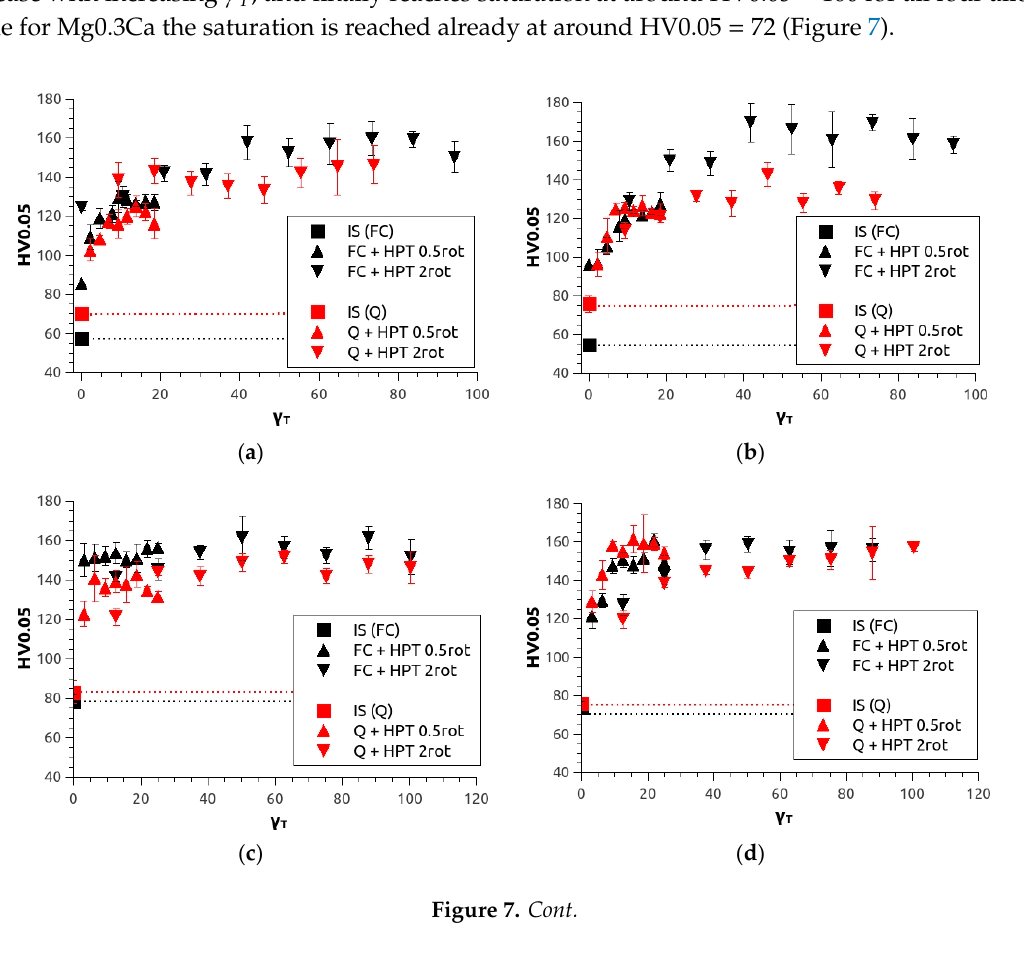
( e ) Figure 7. Microhardness results for ( a ) Mg5Zn0.3Ca, ( b ) Mg5Zn, ( c ) Mg5Zn0.15Ca, ( d ) Mg5Zn0.15Ca0.15Zr and ( e ) Mg0.3Ca in the initial state (IS–dotted line) after furnace-cooling (FC, black) and quenching (Q, red) and additional HPT deformation at room temperature at 4 GPa, 0.5 and 2 rotations giving torsional strains up to γ T ~100. 3.3. The Effects of Isothermal Heat Treatments Microhardnesses of heat-treated alloys in the initial state and HPT-processed state have been reported in [34]. After homogenization, followed by furnace-cooling or quenching, Mg alloy samples